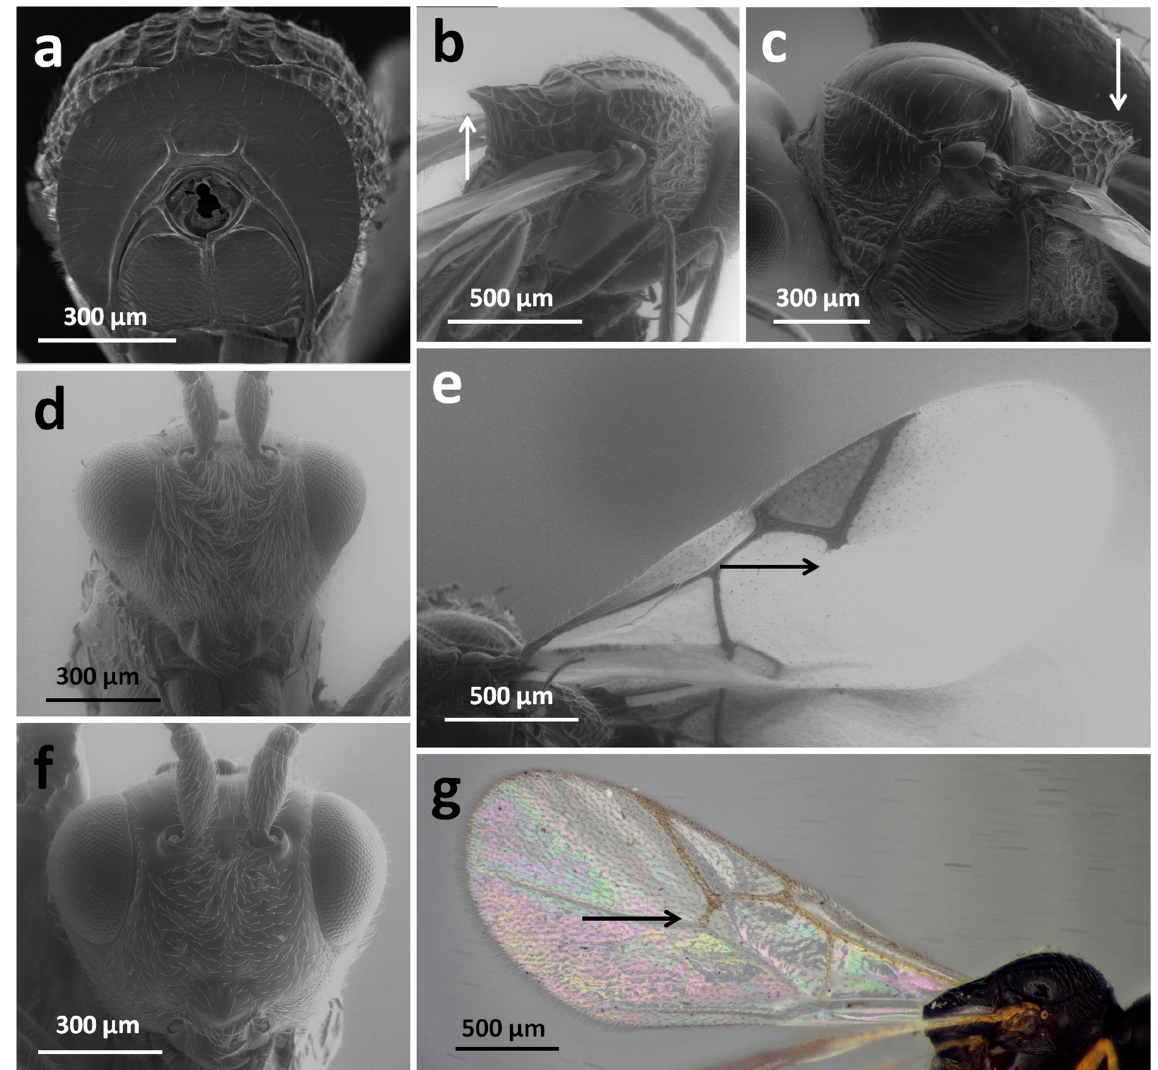
Fig. 1. a . Pronotal plate of Acanthaegilopsis sp. in anterior view. b . Xyalaspis sp., mesoscutum in lateral view. c . Aegilips sp., mesoscutum in lateral view. d . Aegilips zaitzevi Kovalev, 1974, head in anterior view. e . Aegilips nitidulus Dalman, 1823, forewing venation. f . Aegilips romseyensis Fergusson, 1985, head in anterior view. g . Aegilips zaitzevi Kovalev, 1974, forewing